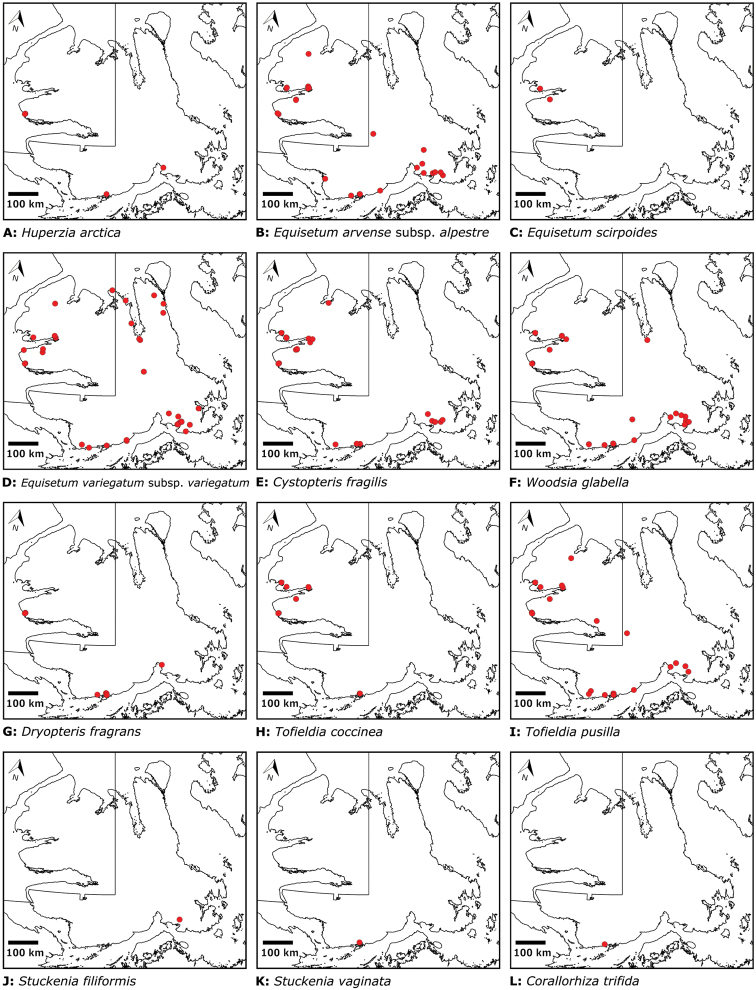
Species distribution maps. Lycopodiaceae: AHuperzia
arctica. Equisetaceae: BEquisetum
arvense
subsp.
alpestreCEquisetum
scirpoidesDEquisetum
variegatum
subsp.
variegatum. Cystopteridaceae: ECystopteris
fragilis. Woodsiaceae: FWoodsia
glabella. Dryopteridaceae: GDryopteris
fragrans. Tofieldiaceae: HTofieldia
coccineaITofieldia
pusilla. Potamogetonaceae: JStuckenia
filiformisKStuckenia
vaginata. Orchidaceae: LCorallorhiza
trifida.